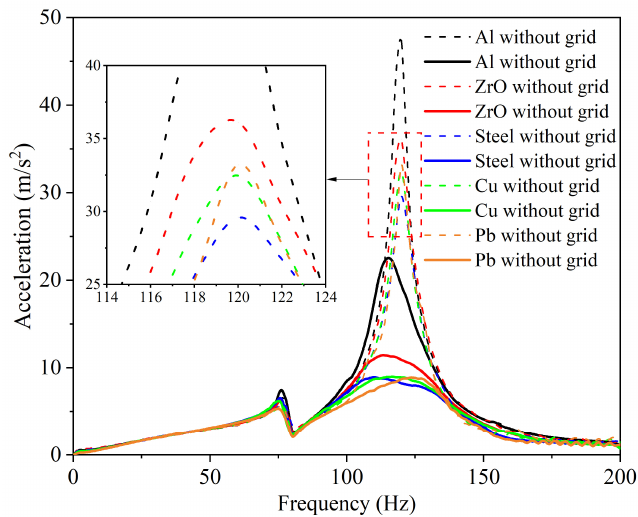
Figure 7. Particle samples of different materials.